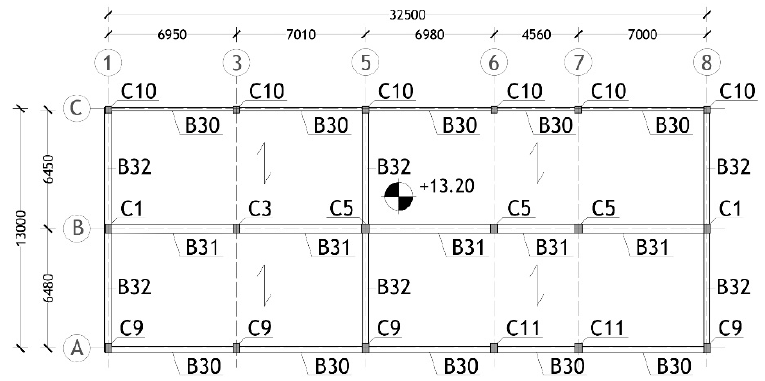
Figure 5. Roof structural plan.